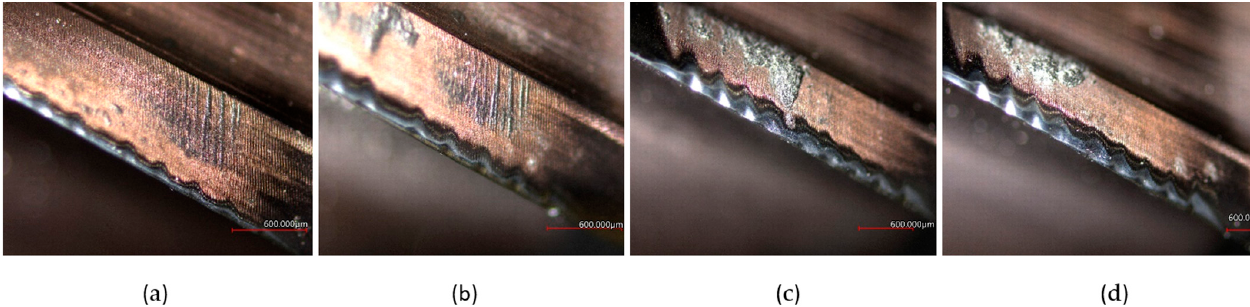
Figure 28. Tool wear of the G550 milling tool, laminate thickness 3 mm. ( a ) Tool tooth path 5 × 165